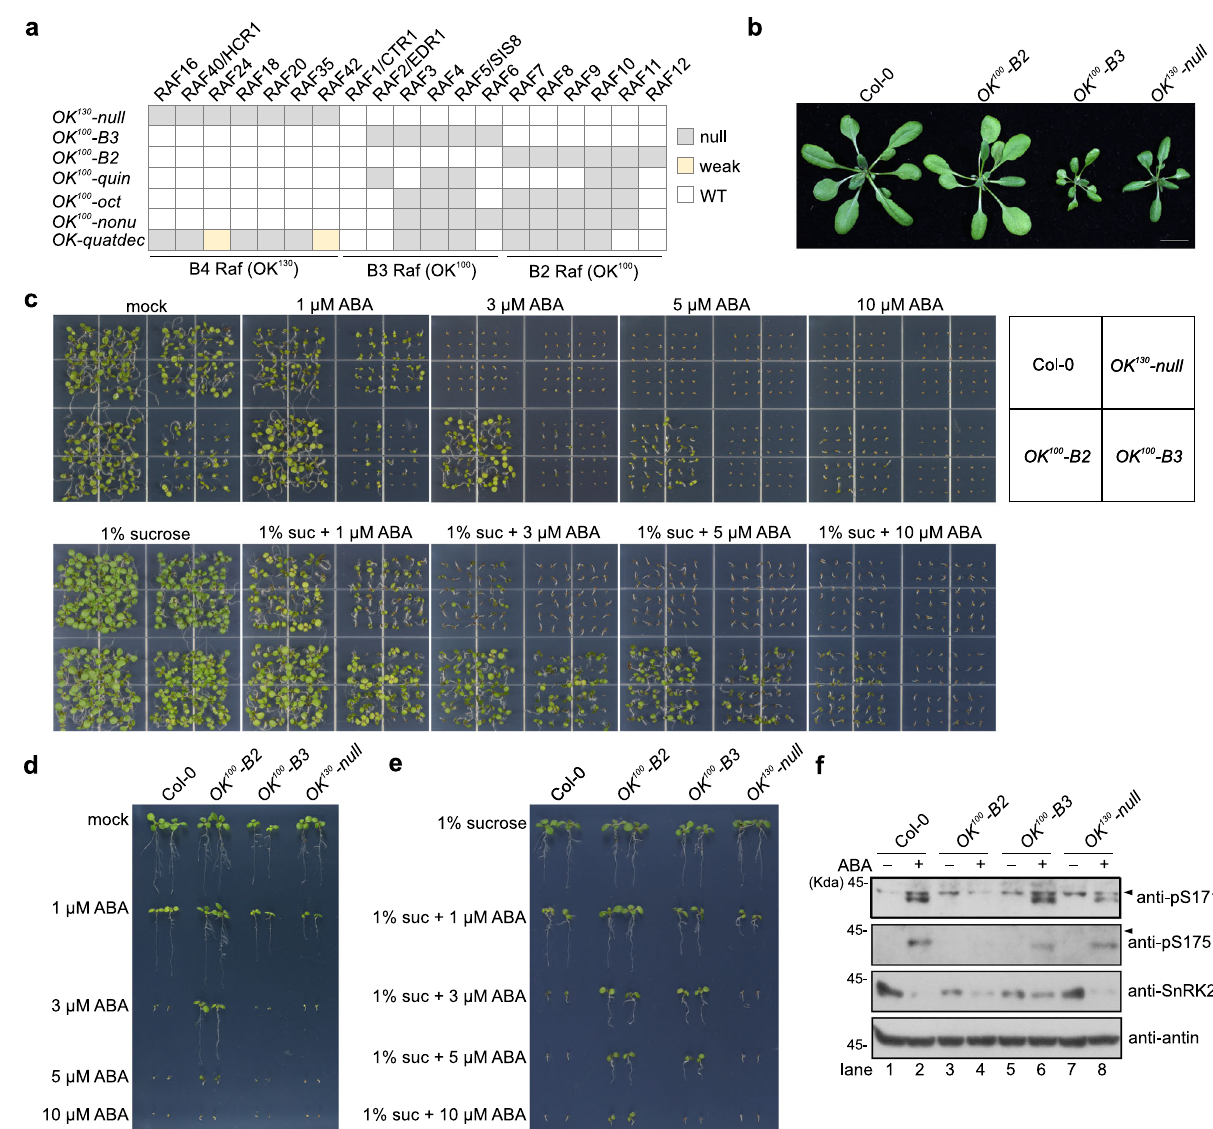
Fig. 3 B2 and B3 RAFs function redundantly in ABA response in vivo. a Mutations of RAF genes in the high-order mutants used in this study. b Photographs of seedlings after 4 weeks of growth in the soil. Bar = 1 cm. c Photographs of seedlings after 10 days of germination and growth on 1/2 MS medium containing indicated concentrations of ABA, without (upper panel) or with (bottom panel) 1% sucrose. The position of mutants in the image is shown in the box at the upper-right corner. d Photographs of seedlings after 10 days of germination and growth on 1/2 MS medium containing indicated concentrations of ABA without sucrose. e Photographs of seedlings after 10 days of germination and growth on 1/2 MS medium containing indicated concentrations of ABA with 1% sucrose. f The ABA-induced phosphorylation of Ser171 and Ser175 of SnRK2.6 in wild-type and the OK 100 -B2 and OK 100 -B3 mutants. The anti-pS171 and anti-pS175 immunoblots were used to show the phosphorylation of the conserved serine residues. Arrows indicate the non- speci fi c bands recognized by anti-pS171 and anti-pS175 antibodies. Images shown are representative of at least two independent experiments. Source data are provided in Source